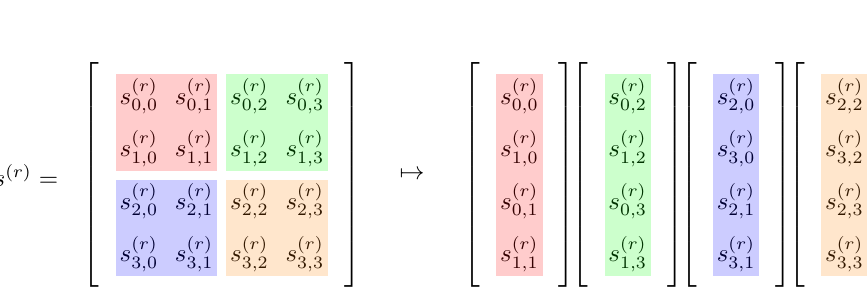
Figure 1: An illustration of quadrant-packed representation (left), as applied to a state matrix (right).